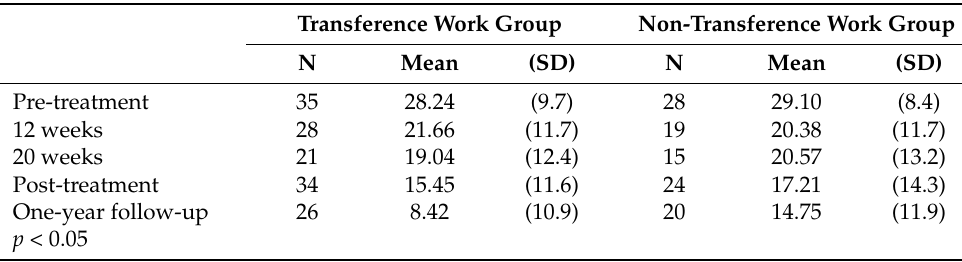
Table 2. Becks Depression Inventory (BDI) measured over time in 69 adolescents receiving short-term psychoanalytic psychotherapy with or without transference work [48].